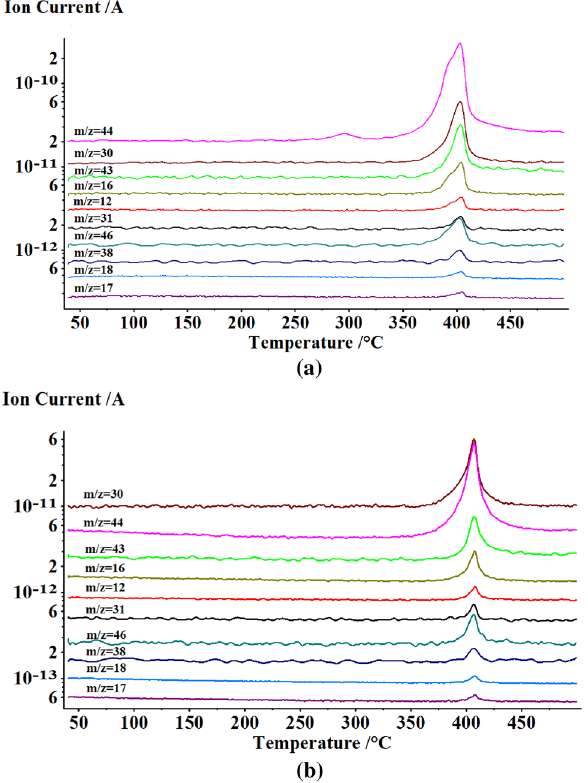
Figure 10. Ion current curves of gaseous products of the thermal decompositions of y-PTACOT ( a ) and z-TACOT ( b ) from simultaneous DSC-TG-FTIR-MS